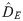
EU-emails: Normalized temporal difference, for the edit distance D^E, and absolute value of the changes in the graph volume over time.